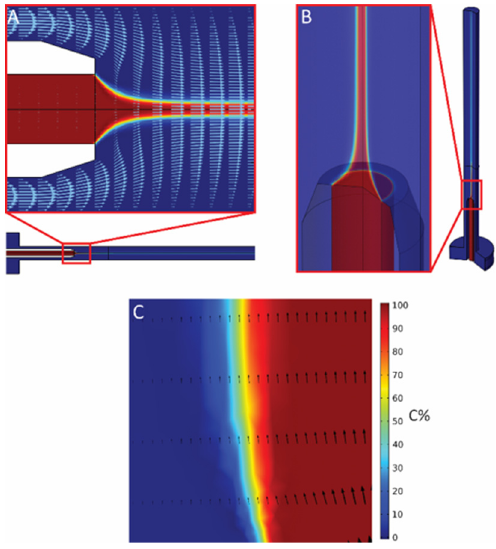
Figure 2. Simulation of the focusing behavior at r = 0.2 with total flow rate of 300 µL/min. ( A ) 2D vector and concentration graph. ( B ) 3D simulation of visualizing flow behavior around the nozzle. ( C ) Concentration gradient at the boundary of the core flow. Polymers 2020 , 12 , 633